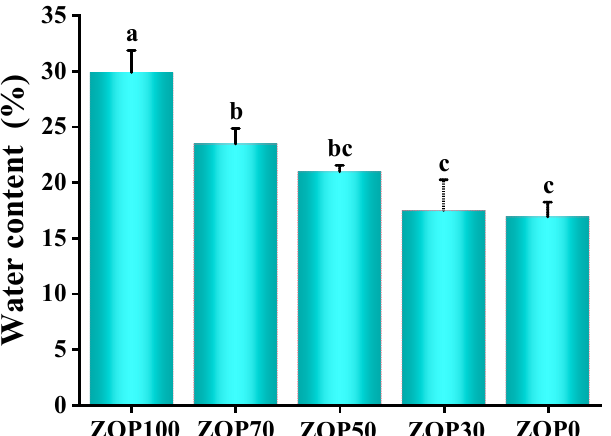
Figure 6. Water-holding capacity of different hydrogels. Note: different letters indicate significant differences in mean values ( p < 0.05).